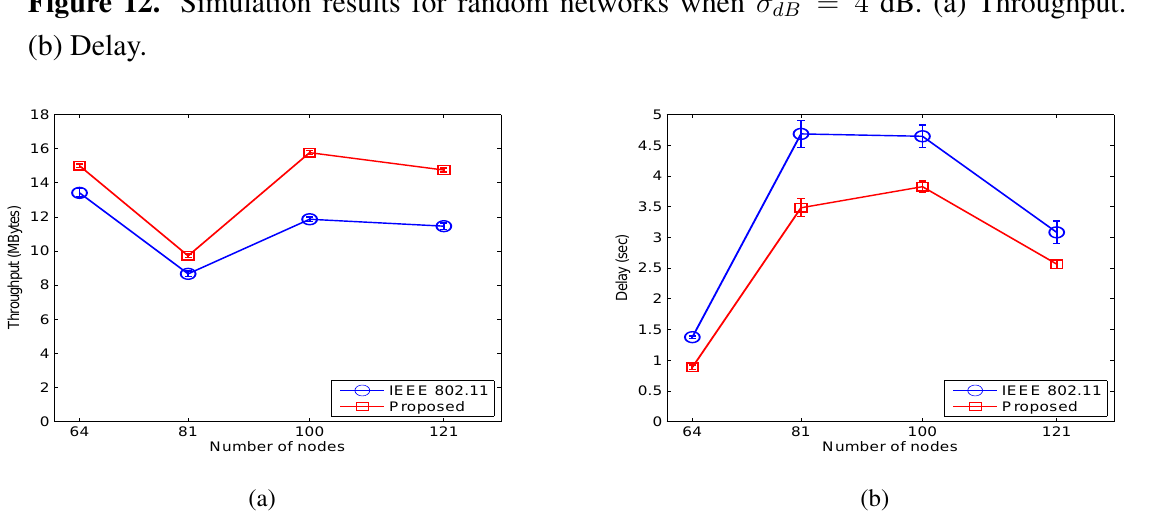
= 4 dB. (a) Throughput. dB